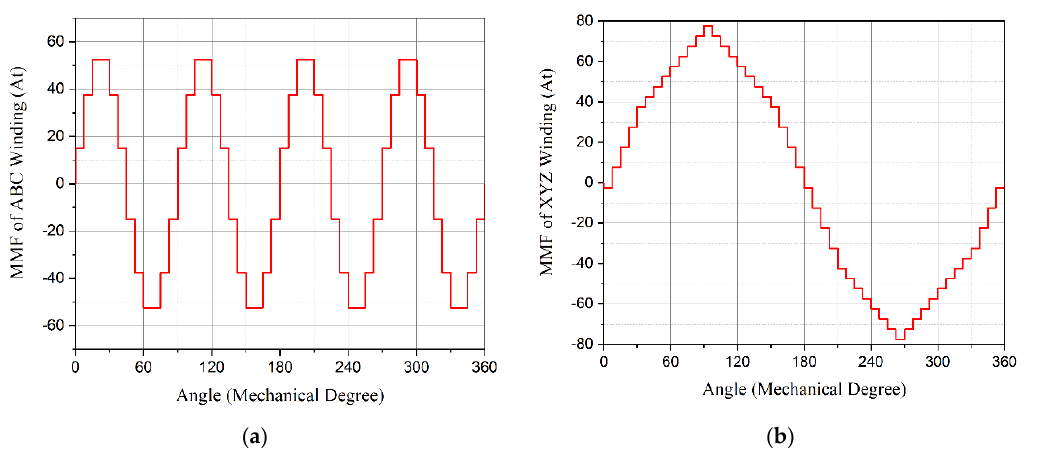
Figure 7. Stator MMF components: ( a ) Fundamental component; ( b ) Sub-harmonic component. Table 1. Design parameters of the proposed SHSM.